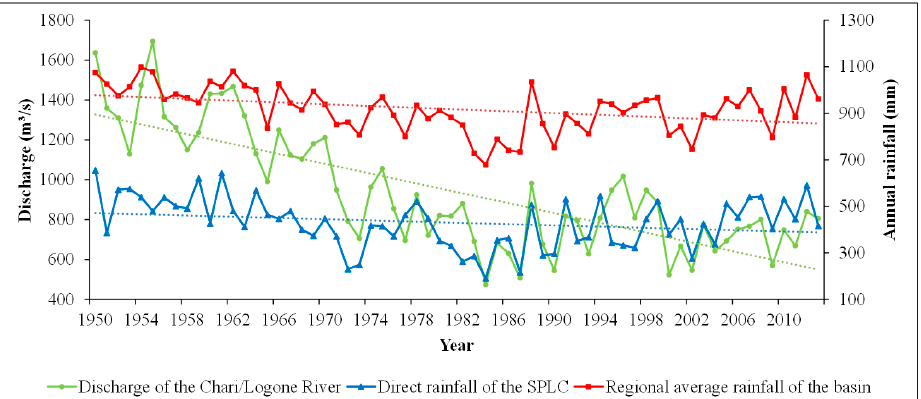
Figure 3. Time series of monthly discharge of the Chari/Logone River, the direct rainfall of the southern pool of Lake Chad (SPLC) and the regional average rainfall of the whole basin.